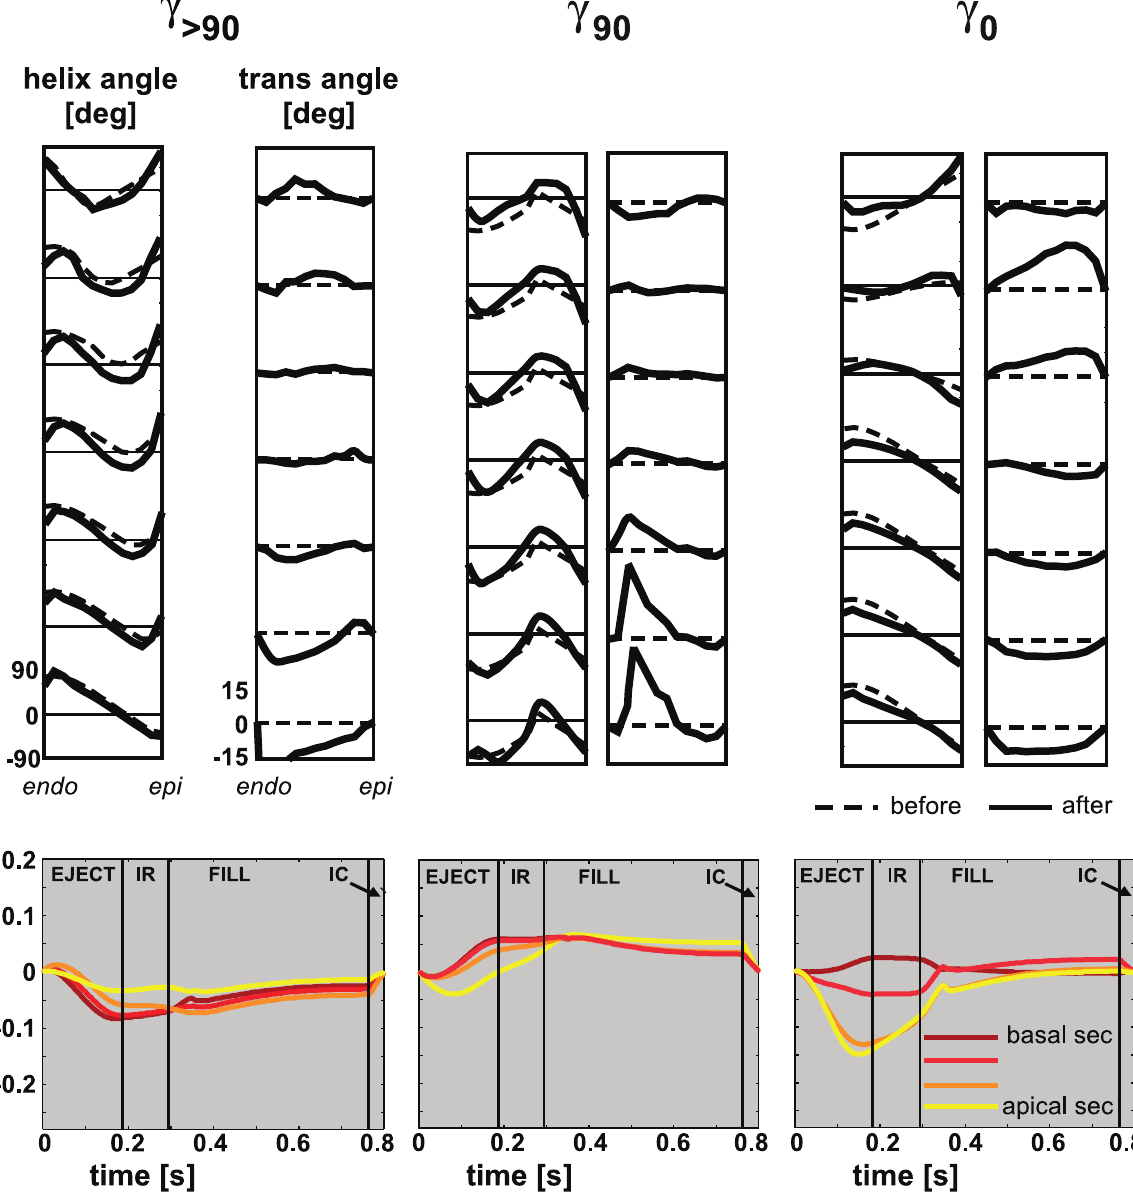
Figure 10. Results of additional simulations. The additional simulations were performed with a variation on simulation MID (with c mid , see figure 3 for definition of c ): c w 90 ( c w 90 ~ 180 { c mid ), c 90 , and c 0 , where the subscript 90 and 0 refer to a c of 90 0 and 0 0 , respectively. Top : Transmural distribution of a h ,0 and a t ,0 before ( 2 2 ) and after 15 adaptation cycles ( 2 ) at 7 levels between apex and base. Major pattern of a h ,0 remained closed to the initial distribution, while a non-zero distribution for a t ,0 developed. Bottom : Torsion patterns [rad] after 15 adaptation cycles. Amplitudes of torsion have decreased significantly after reorientation as compared to amplitudes before reorientation. doi:10.1371/journal.pcbi.1002611.g010 PLoS Computational Biology |